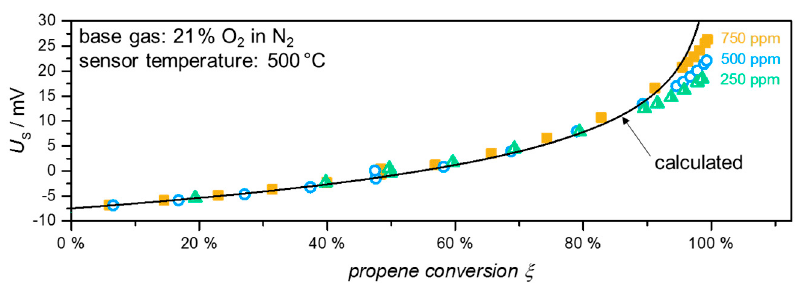
Figure 3. Sensor signal over propene conversion on simulating catalyst behavior for different propene feed concentrations, while the sensor temperature was set to 500 °C. The black curve is calculated from Equation (1) with U s ( ξ = 0) = 7.5 mV, for the present sensing principle. Conflicts of Interest: The authors declare no conflict of